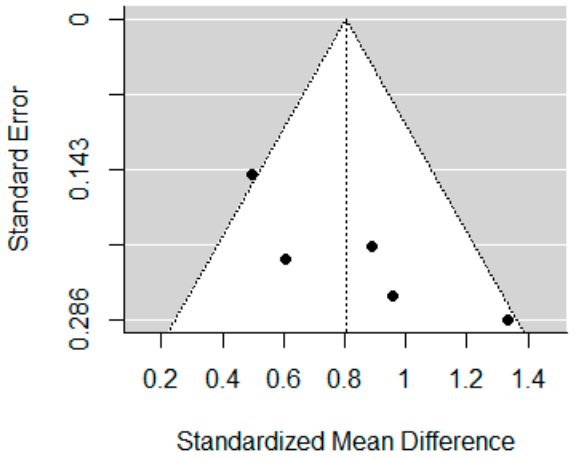
Figure 7. Funnel plot for studies included in the inattention